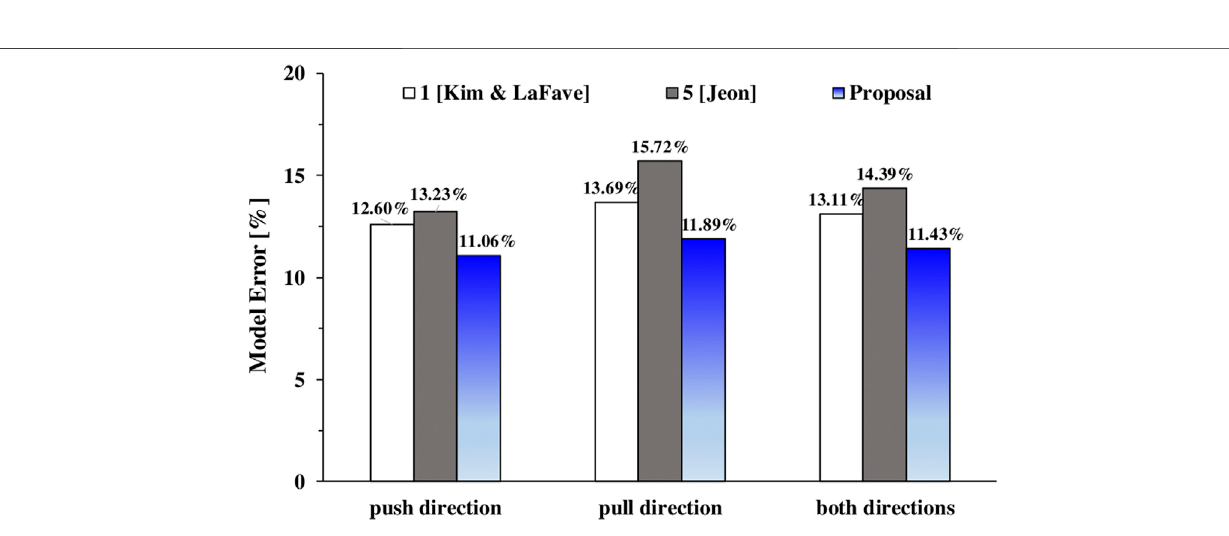
Frontiers in Materials |